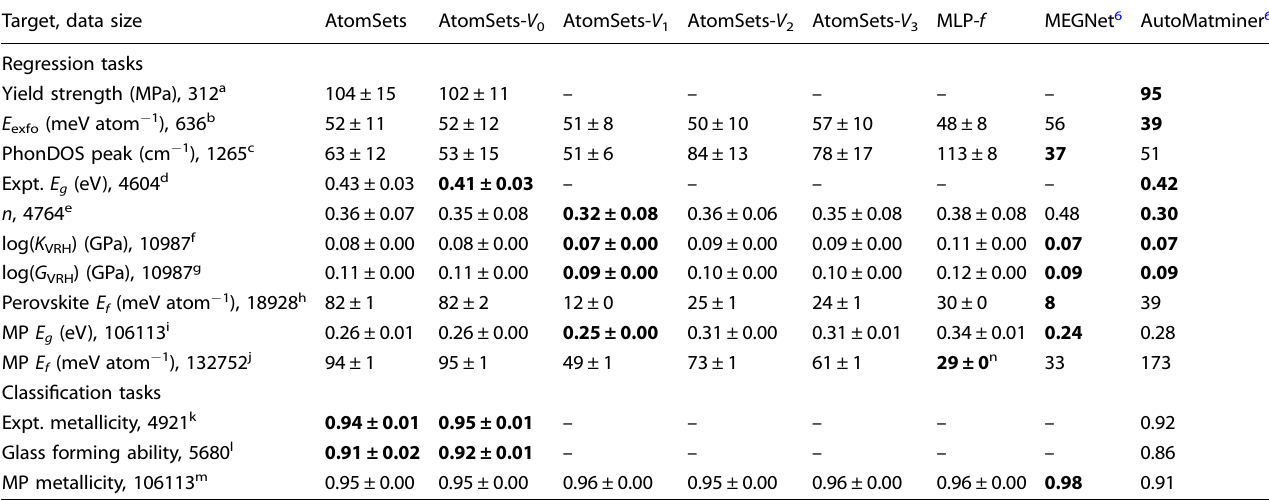
Table 2. Performance of AtomSets models relative to state-of-the-art models using the same fi ve-fold random splitting methods and the random seed of